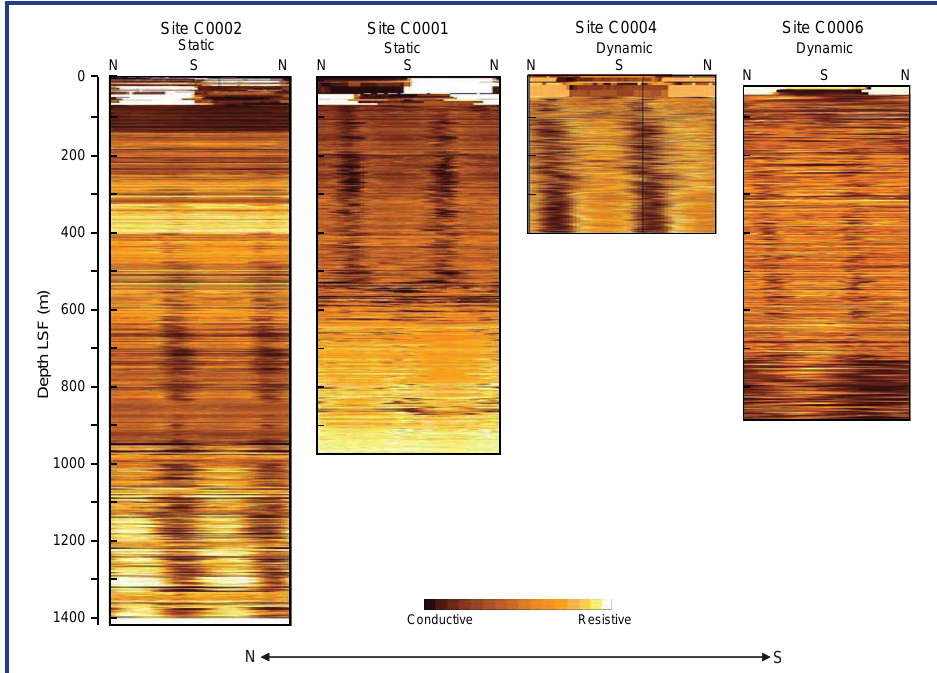
Figure 9. Resistivity at bit images synoptically showing full depth extent of LWD logged intervals at Sites C0001, C0002, C0004, and C0006. Vertical paired dark bands are images of borehole breakouts that have been interpreted in order to generate the average SH max azimuths shown in Figure